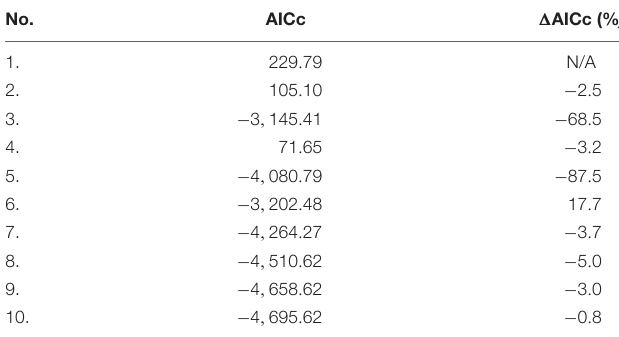
TABLE 4 | Adjusted Akaike information criterion (AICc) values and percent improvement in AICc with respect to the scenario 1 baseline ( (cid:49) AICc) for each fitting scenario.